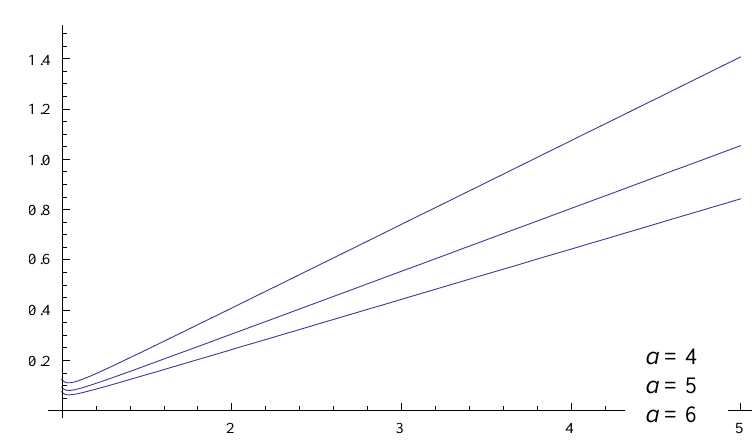
Figure 1. The impact of parameter a on the MRL of the constrained ( k , d )-out-of- n : F system.